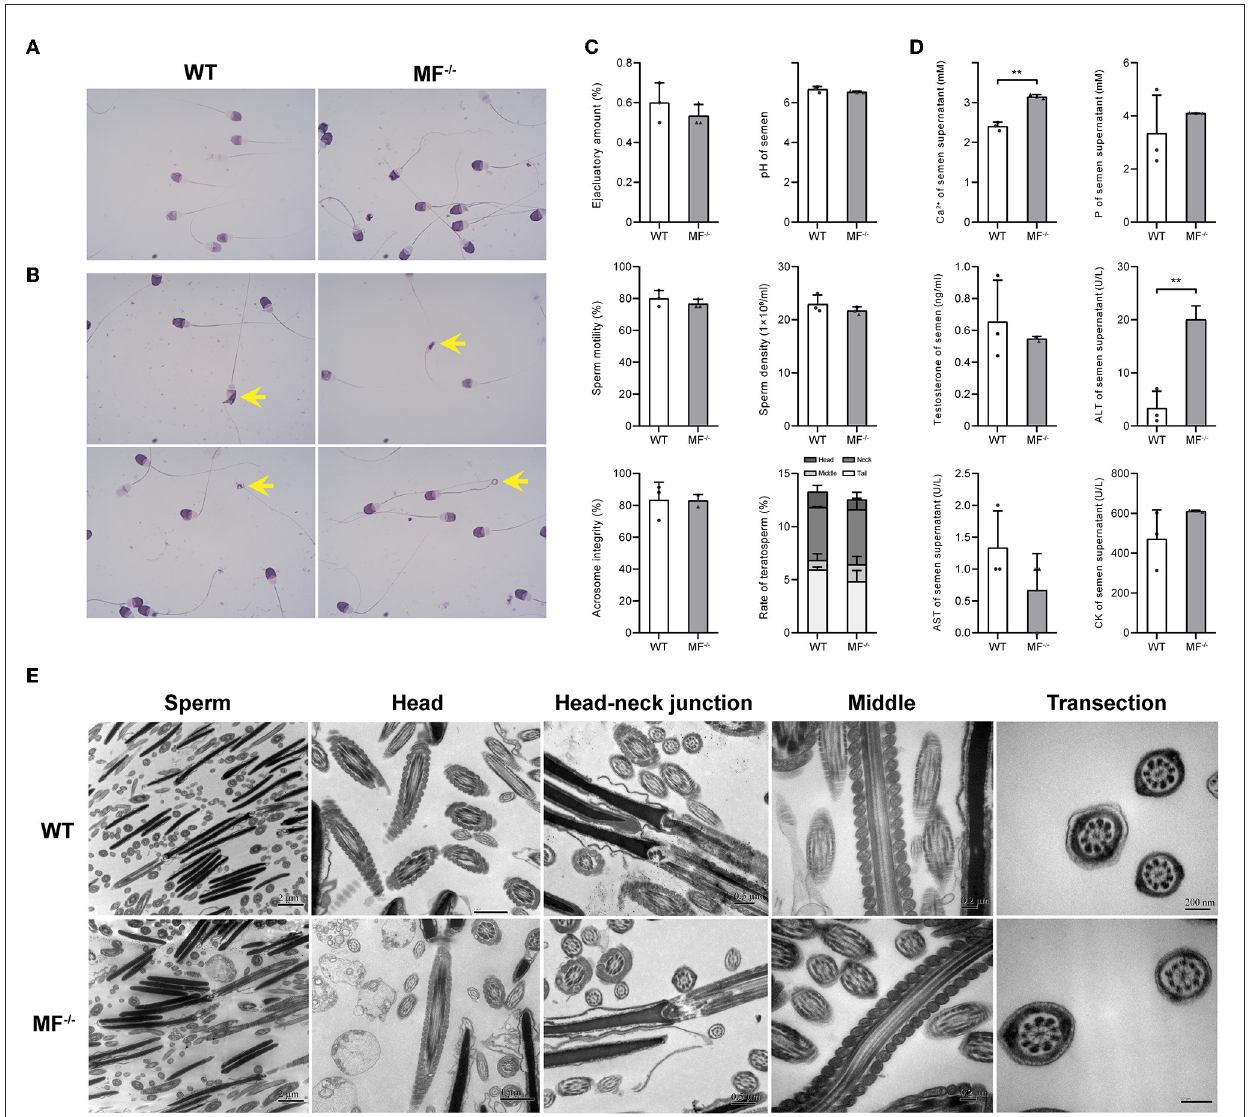
FIGURE1 The reproductive safety evaluation of genome editing ram. (A) Giemsa stained ram sperm in WT and MF –/- sheep. (B) Different types of teratosperm. (C) Comparison of the semen quality between WT and MF –/- sheep. (D) Comparison of the seminal plasma biochemical index between WT and MF –/- sheep. (E) Comparison of the semen ultrastructure between WT and MF –/-